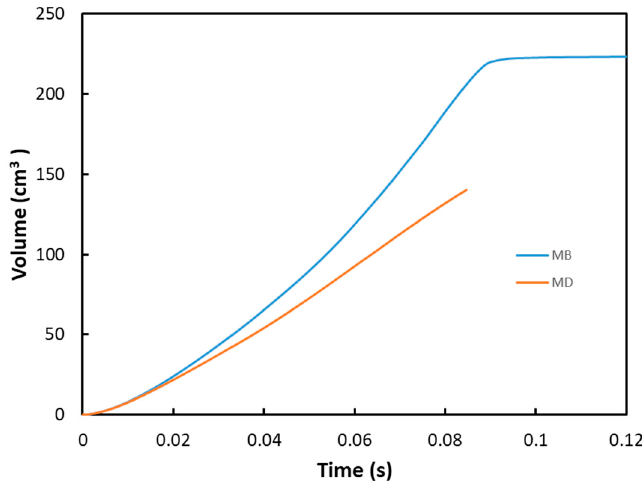
Figure 10. Internal pressure versus volume of PMSQ–HDPE.